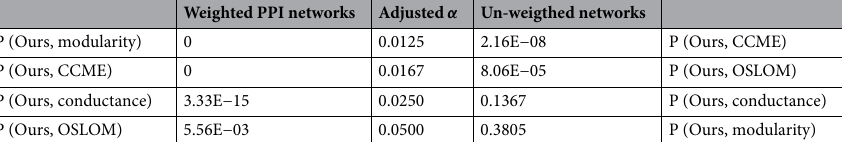
Weighted PPI networks Adjusted α Un-weigthed